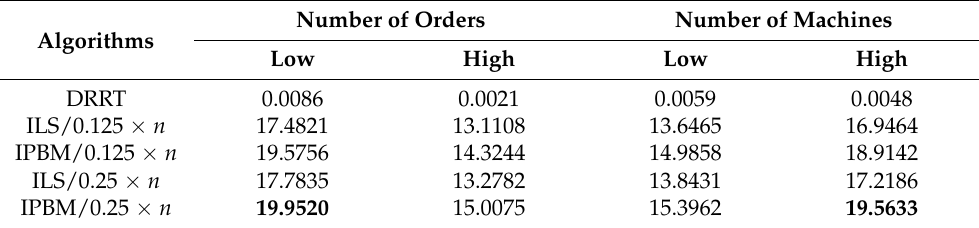
Table 4. Results for different number of orders and number of machines (in RPD). Algorithms